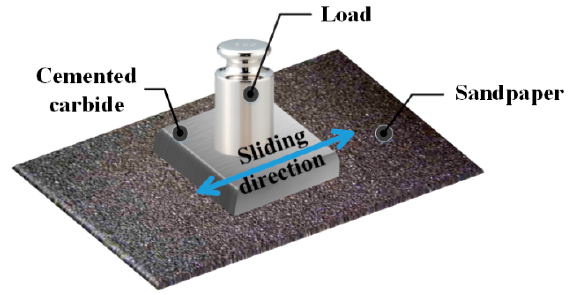
Figure 3. Schematic representation of the rubbing test.